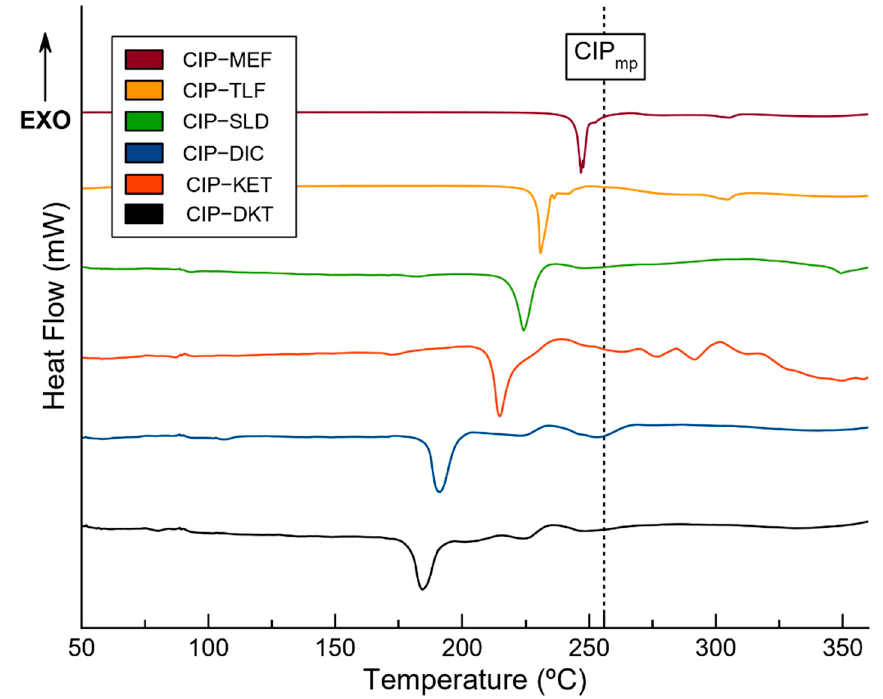
Figure 9. DSC traces for the pure molecular salts and the melting point of the CIP drug [51] (black dotted line).